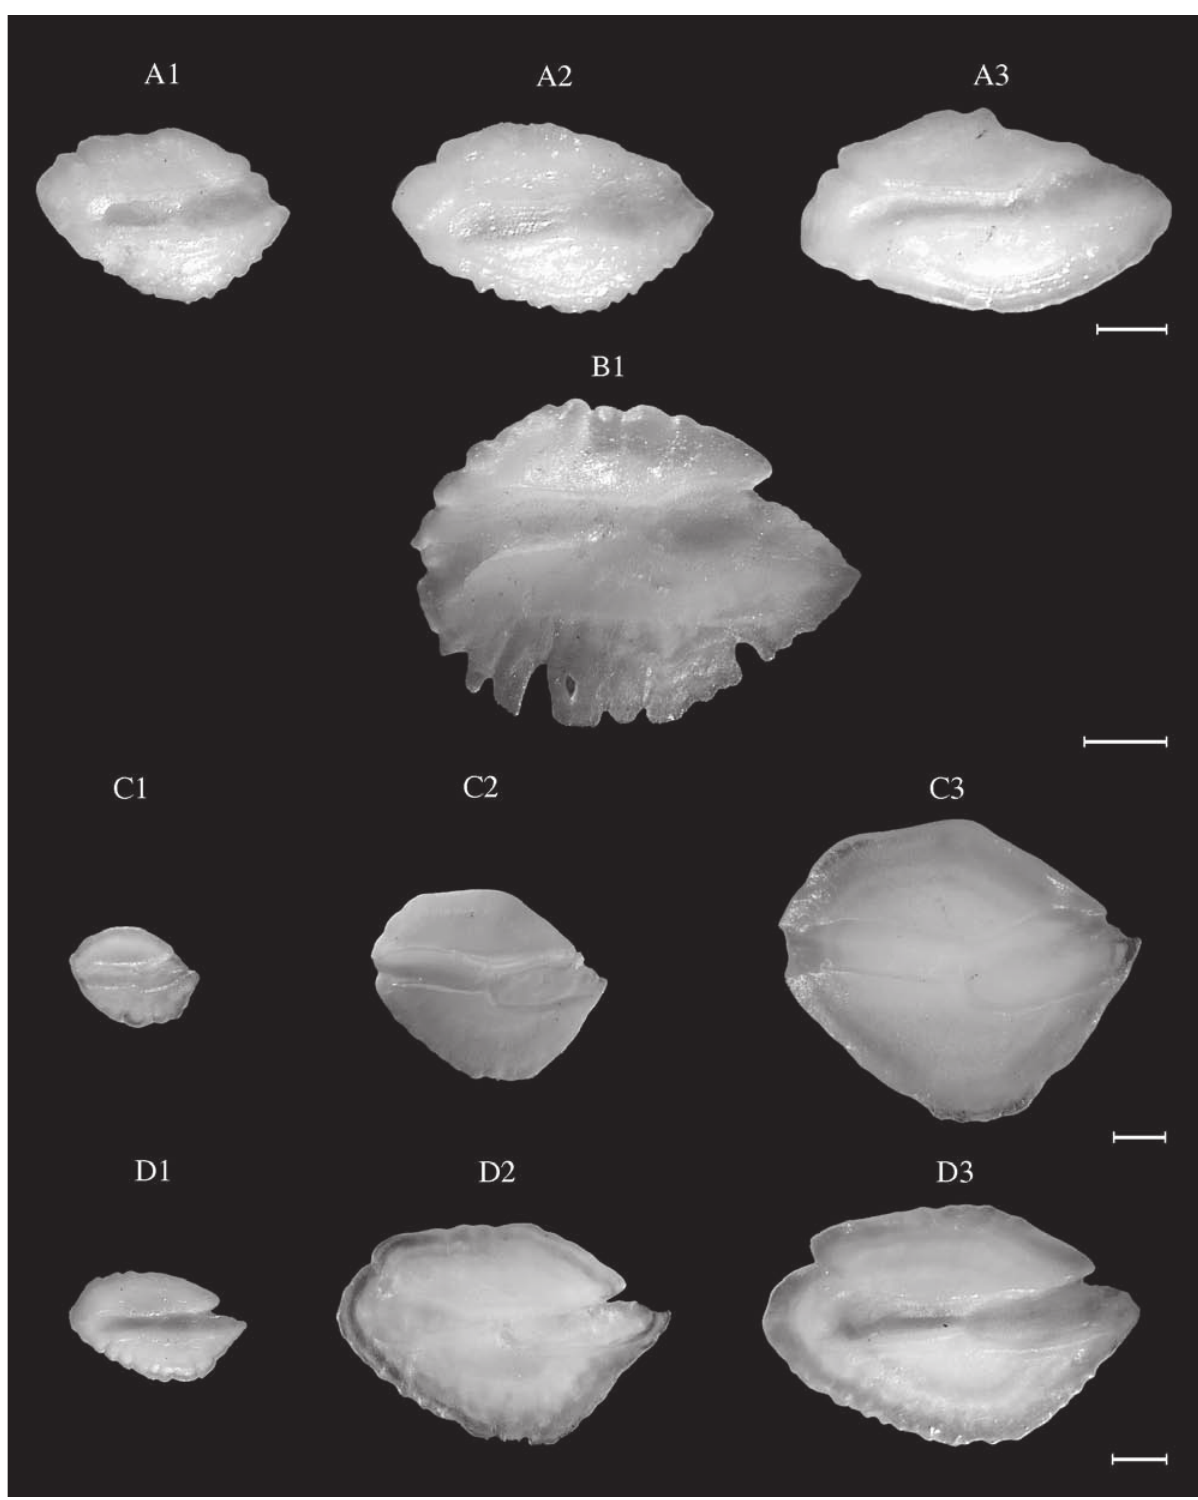
Fig. 50. – Callanthias ruber (WM). TL: A1, 14.0 cm; A2, 15.0 cm; A3, 18.0 cm. Heteropriacanthus cruentatus (CEA). TL: B1, 20.1 cm. Epigonus constanciae . TL: C1, 3.5 cm (WM); C2, 6.0 cm (CEA); C3, 13.2 cm (NEA). Epigonus denticulatus . TL: D1, 6.3 cm (WM); D2, 12.5 cm (NEA); D3, 16.5 cm (WM). Scale bar = 1